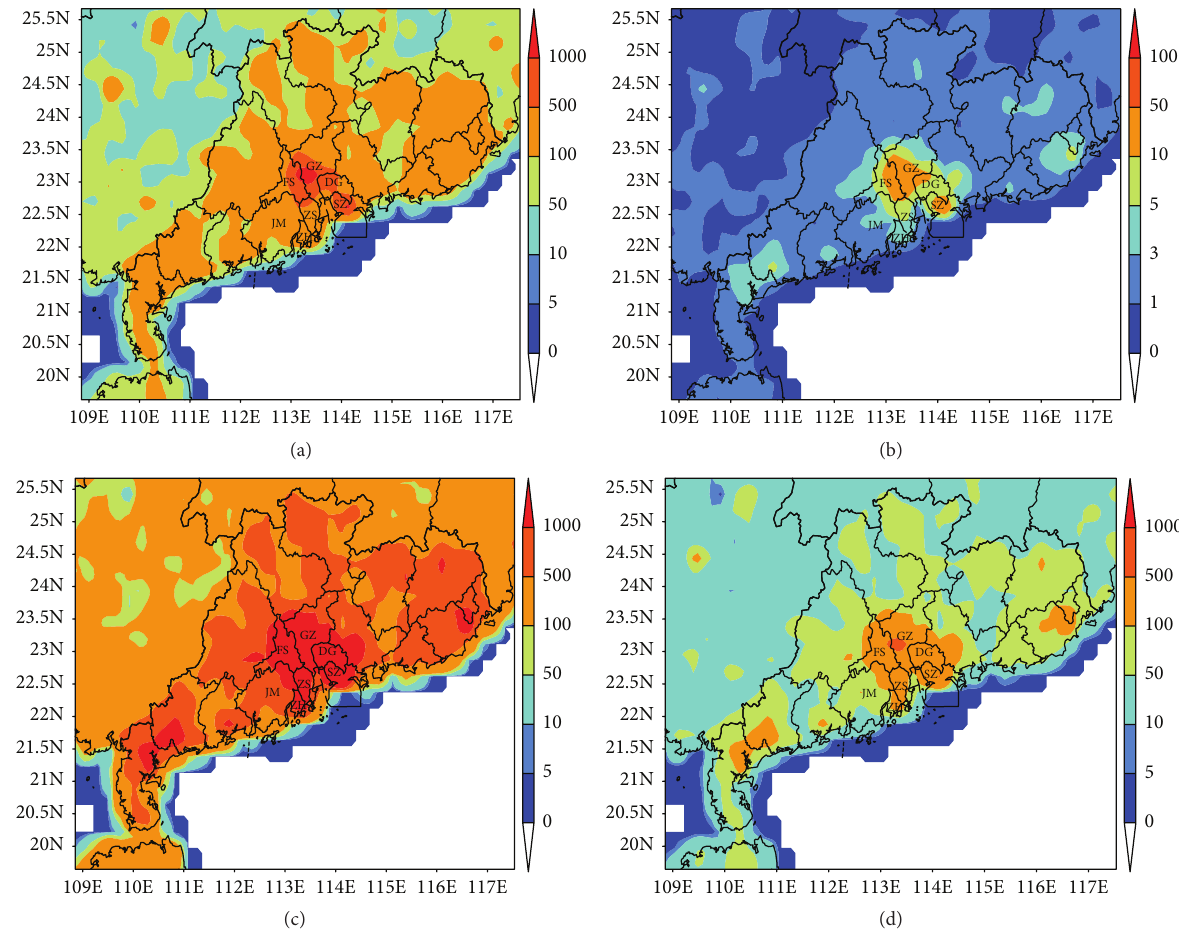
Figure 2: Annual emissions of (a) NO 𝑥 , (b) SO 2 , (c) CO (unit: × 10 6 mol/year/grid), and (d) PM 2.5 (unit: × 10 3 kg/year/grid) in the inner domain of CMAQ (cities in the PRD: Zhongshan (ZS), Guangzhou (GZ), Foshan (FS), Jiangmen (JM), Zhuhai (ZH), Dongguan (DG), and Shenzhen